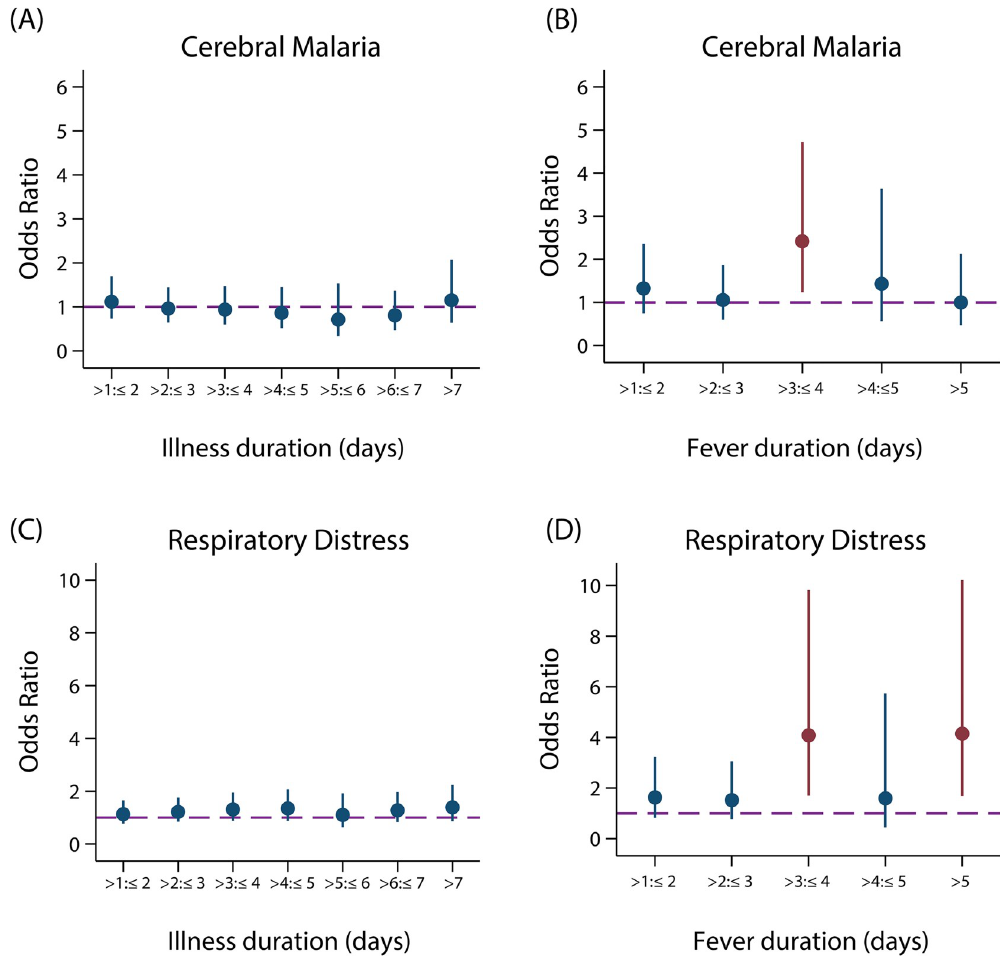
Fig 5. Treatment delay and odds of presenting with CM (A–B) and respiratory distress (C–D) in children < 15 years. ORs (and 95% CIs) for presentation with severe disease with each additional reported day of illness before attending the health facility compared with patients attending within 1 day of reported illness onset (A and C; N UM = 3,277, N CM = 737, N RDS = 945) or fever onset (B and D; N UM = 492, N CM = 441, N RDS = 251). ORs were obtained from a mixed-effects logistic regression adjusted for age as a linear predictor and allowed for random study effects. Statistically significant ORs are denoted in red (dashed purple line: OR = 1). The same plots for other SM phenotypes are shown in S9 Fig. CM, cerebral malaria; OR, odds ratio; RDS, respiratory distress syndrome; SM, severe malaria UM, uncomplicated